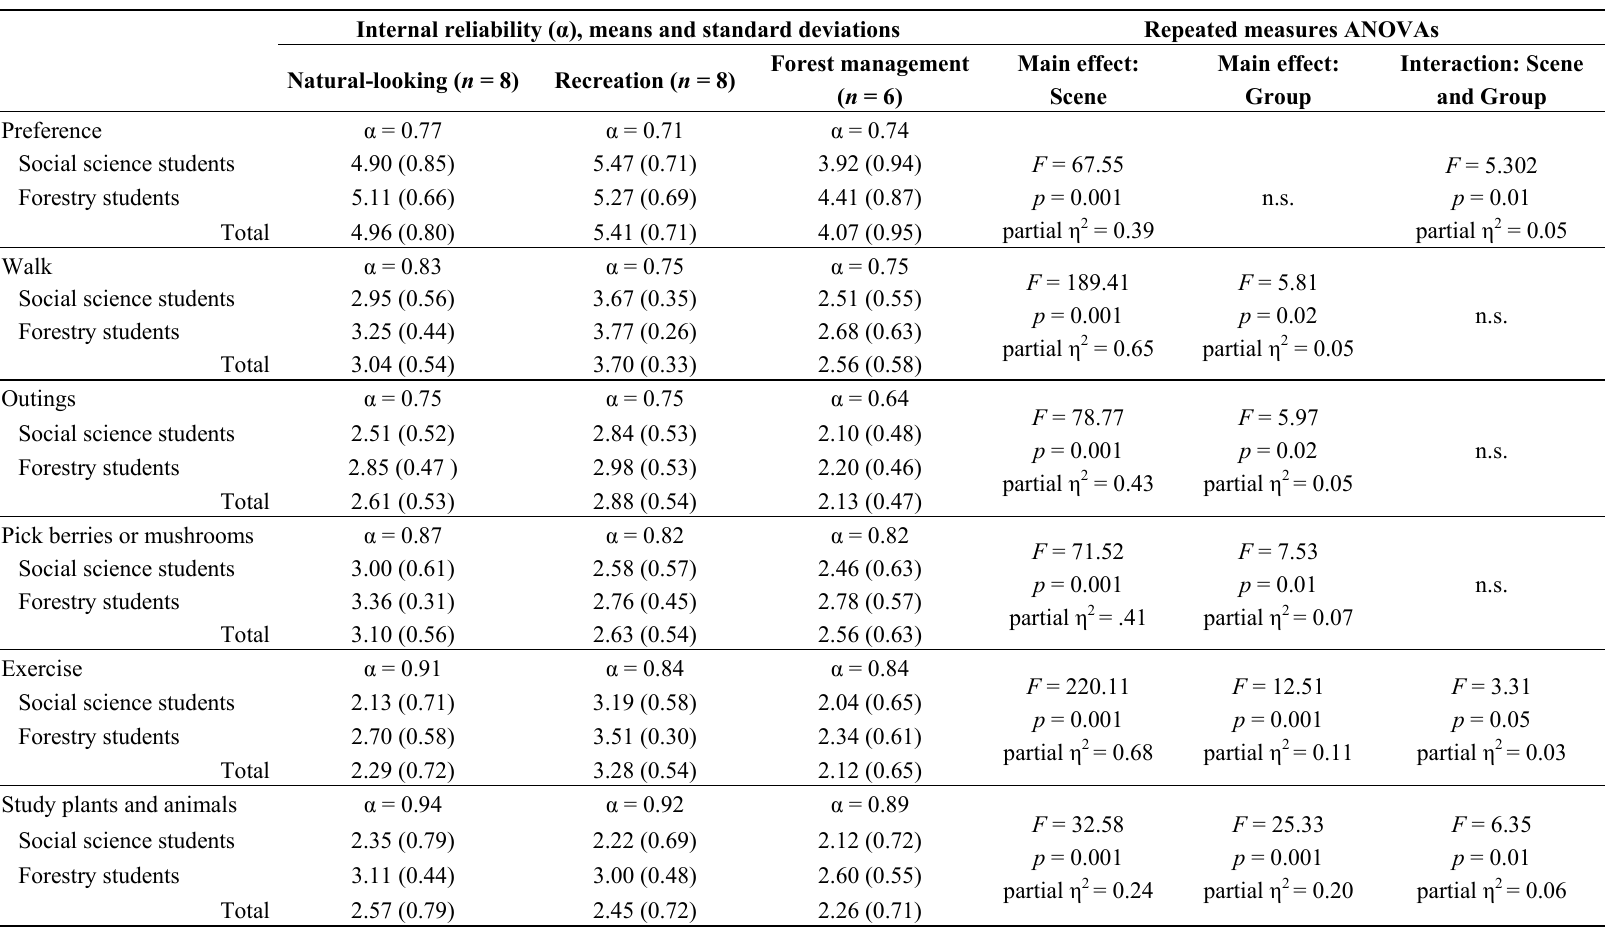
Table 3. Internal reliability ( α ), means, standard deviations, and results from the repeated measures ANOVAs in relation to preference and intention to engage in activities in settings with different types of human intervention ( i.e. , natural-looking, settings with traces of recreation, and settings with traces of forest management) among the social science and forestry